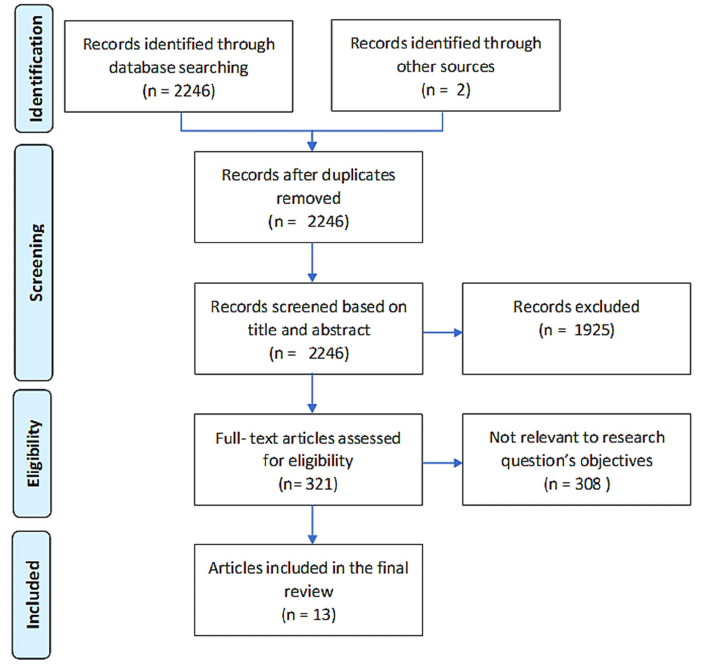
Figure 1. Flow chart.